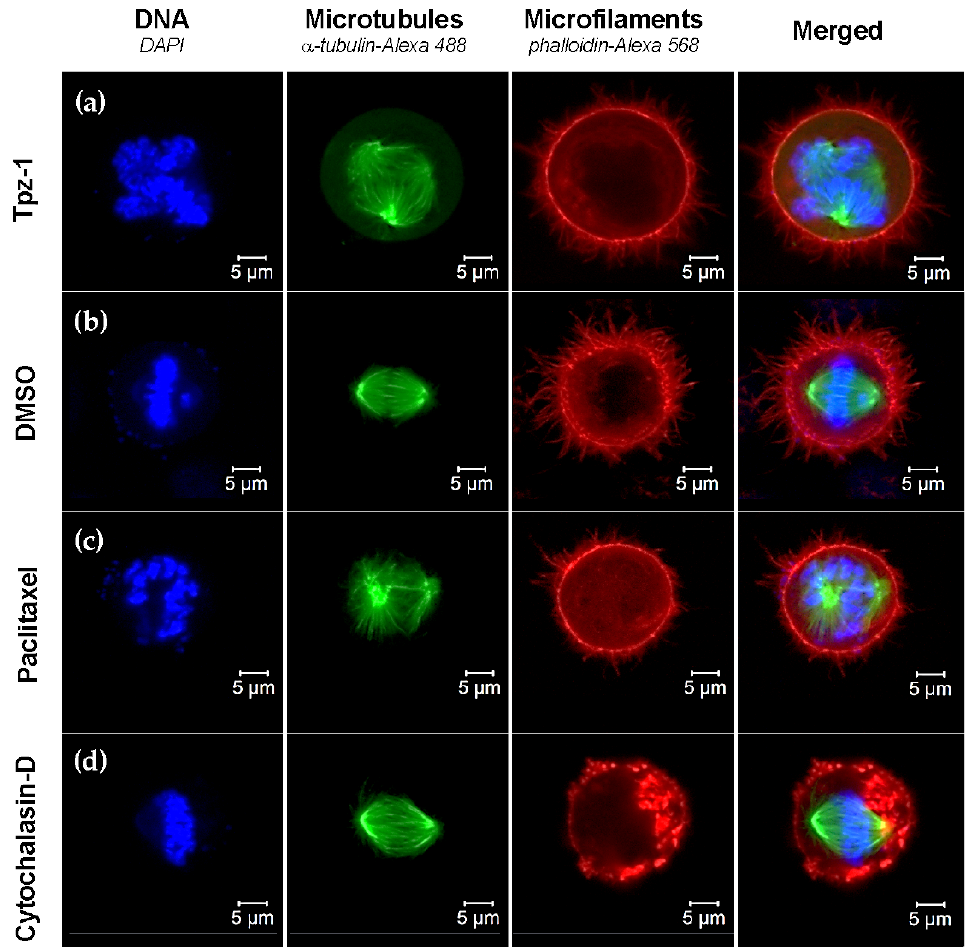
Figure 7. Tpz-1 (0.19 µ M) disrupts spindle formation and polarity in HeLa cells undergoing mitosis. ( a ) Tpz-1, ( b ) 1% v / v DMSO, ( c ) 1 µ M Paclitaxel, and ( d ) 5 µ g/mL Cytochalasin-D treated cells